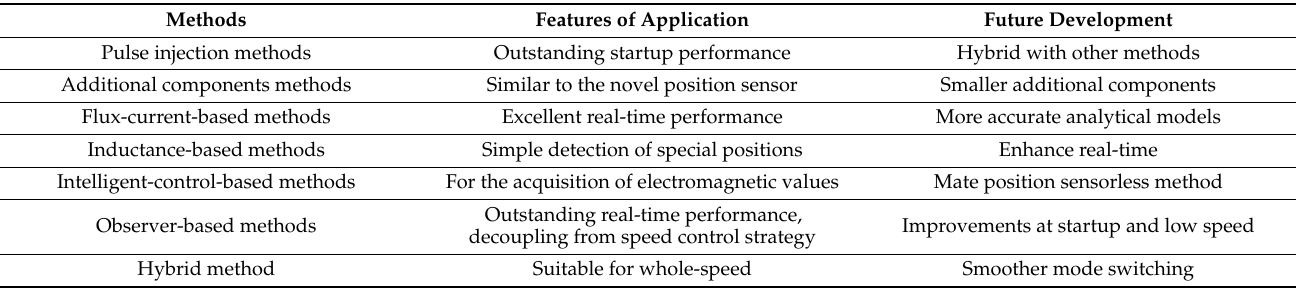
Table 3. Prediction of the development of existing